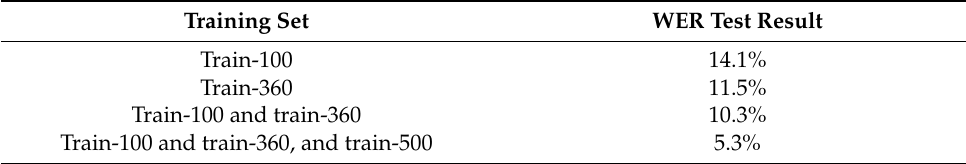
Table 4. Evaluations of automatic speech recognition